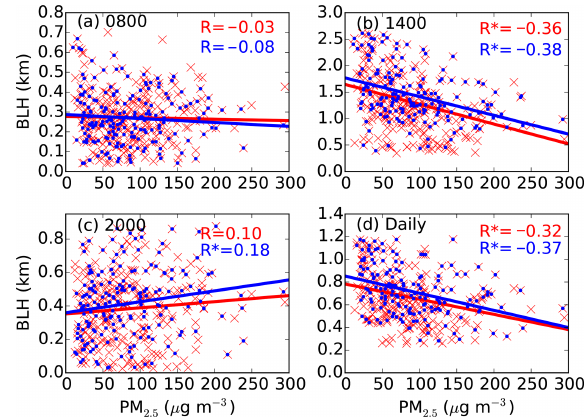
Figure 4. The BLH as a function of daily PM 2 . 5 concentration at (a) 08:00BJT, (b) 14:00BJT, (c) 20:00BJT, and (d) averaged over the whole day (in red). BLHs greater than the 95th percentile value and less than the 5th percentile value are not included in the plots. The correlations between the PM 2 . 5 concentration and BLH without considering measurements made on rainy days are shown in blue. The correlation coefficients ( R ) are given in each panel, and the asterisks indicate values that are statistically significant ( p < 0 . 05). The p values were calculated based on the Student’s t